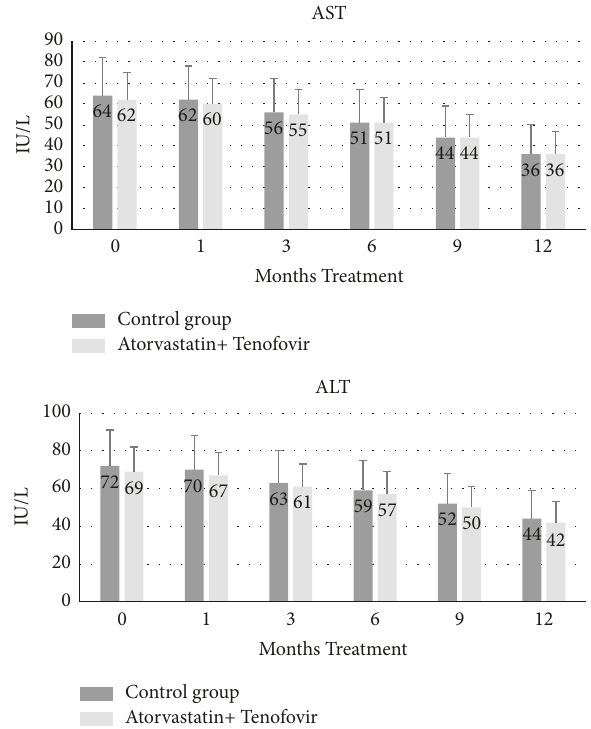
Figure 1: The effect of treatments on liver function. Serum levels of AST and ALT were measured in control patients treated with tenofovir (control) compared with patients treated with tenofovir and atorvastatin (atorvastatin+tenofovir). Data are the mean+SD of 20 patients and were analyzed by two-way ANOVA. At each time point, there is no significant difference between treatments, for either AST or ALT, but both treatments resulted in significantly decreased levels of enzymes compared with levels at the start of treatments (all p < 0 .